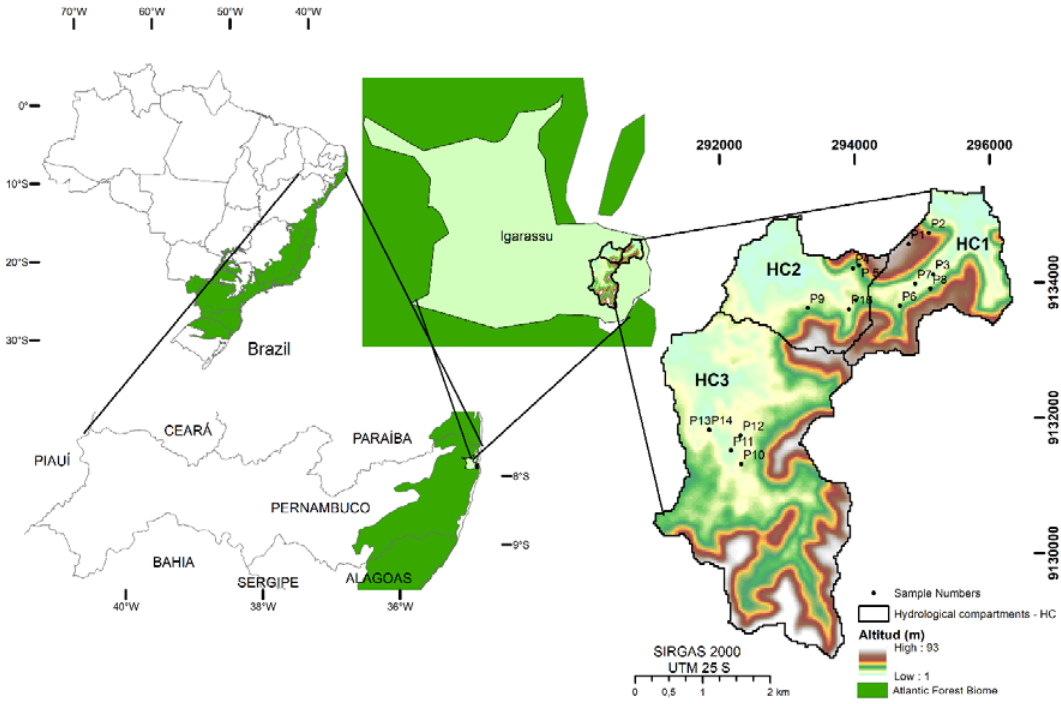
Figure 1. The location of the study area is an anthropized rural area from the Atlantic Forest Biome in Brazil, State of Pernambuco, Igarassú Municipality. Brazil, State of Pernambuco, Igarass ú